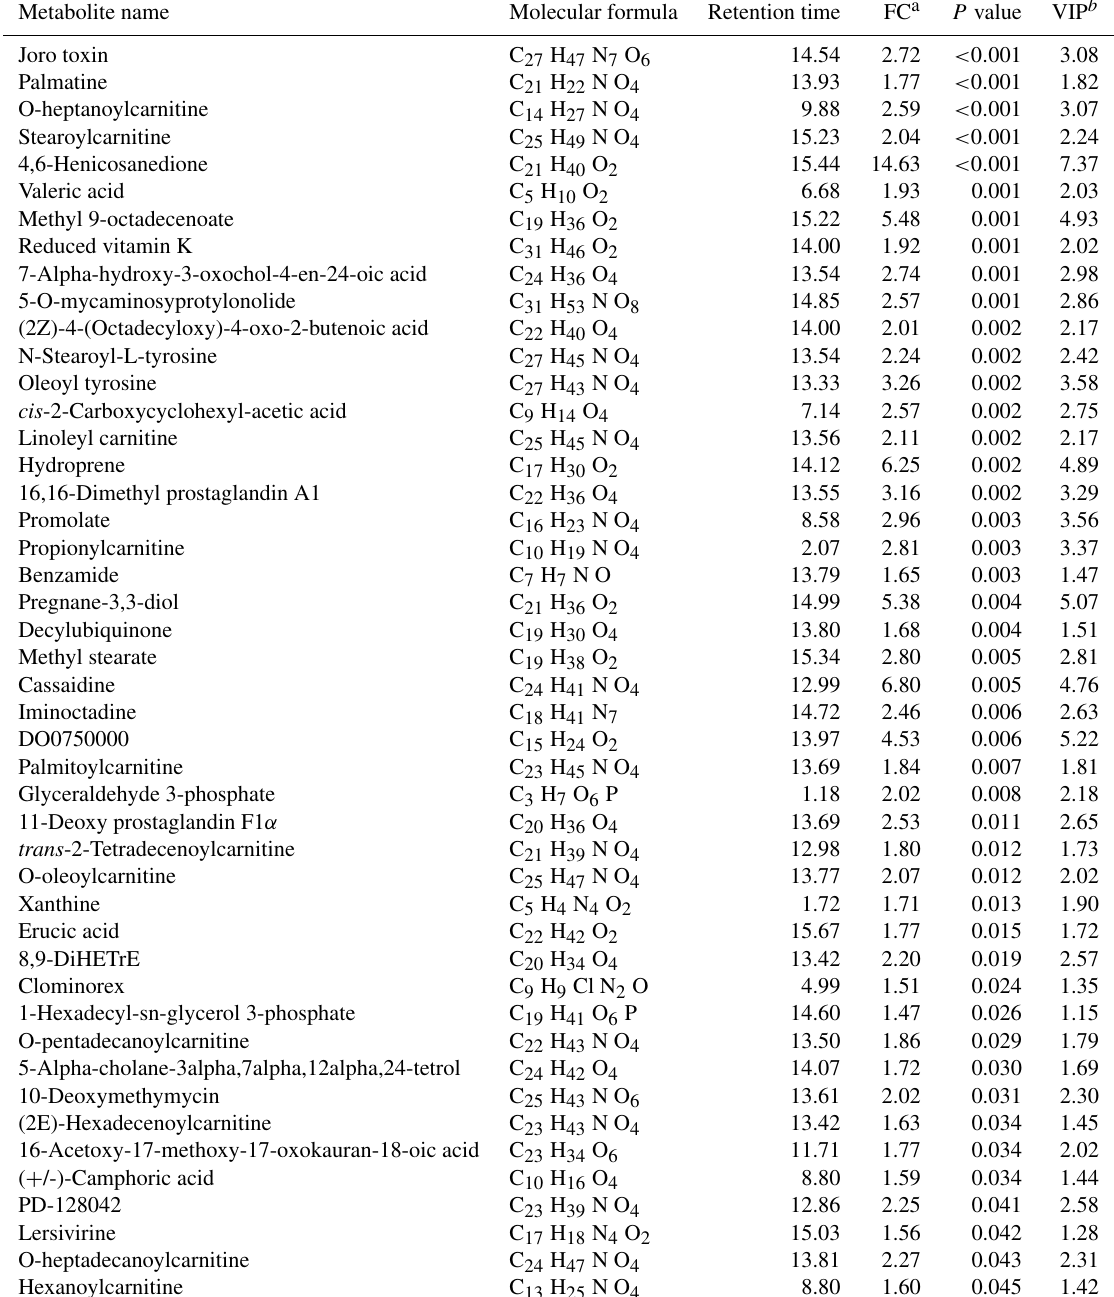
Table 1. Increased metabolites for the agomiR-499-treated group compared with the